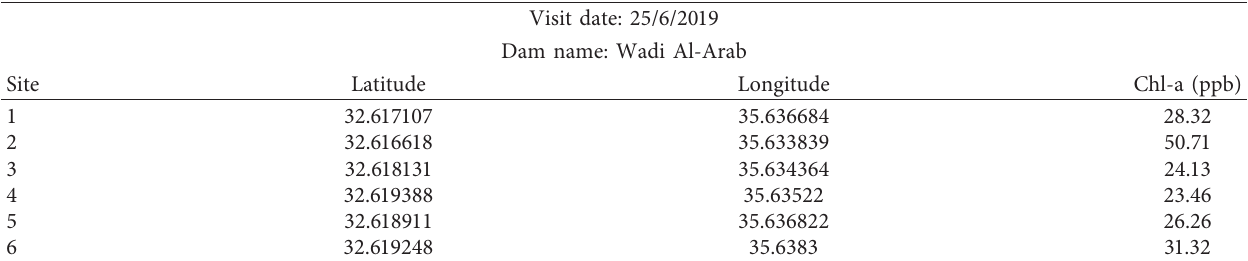
Table 3: Chl-a concentration and corresponding sampling points’ coordinates of samples collected from Wadi Al-Arab